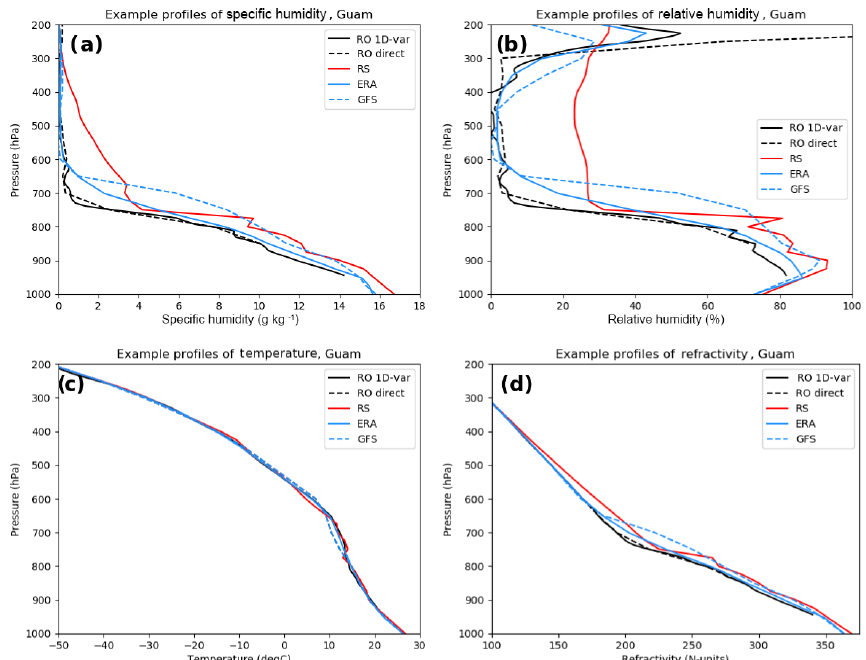
Figure 3. Profiles of specific humidity (a) , relative humidity (b) , temperature (c) , and refractivity (d) for the five data sets for 13 January 2007 at 00:23UTC.